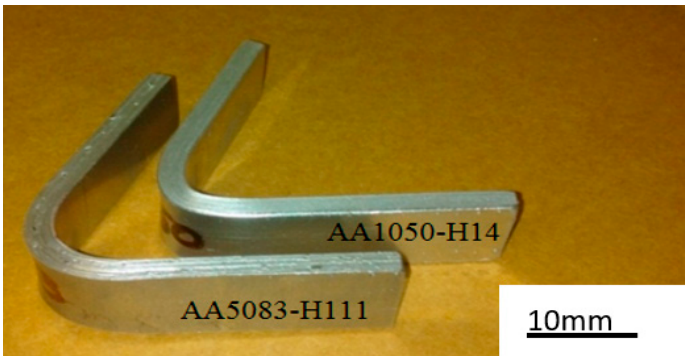
Figure 13. Tested bending specimen (parent materials).